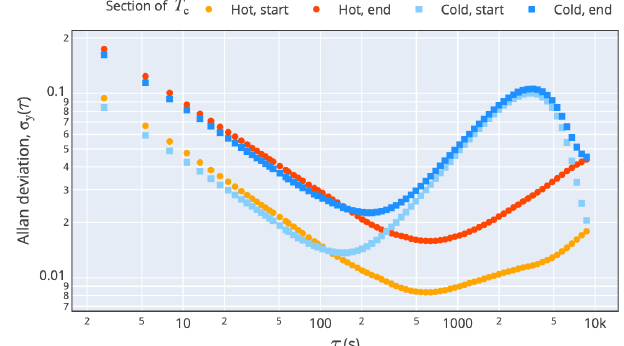
Figure A6. Allan deviation for four DTS range gates in different sections of the fibre-optic cable, in cold and hot baths and at the start and end of the cable, respectively. The − 1 slope towards high fre- quency ( τ < 100s) indicates white noise. Calculations were made before calibration on 24h of T c